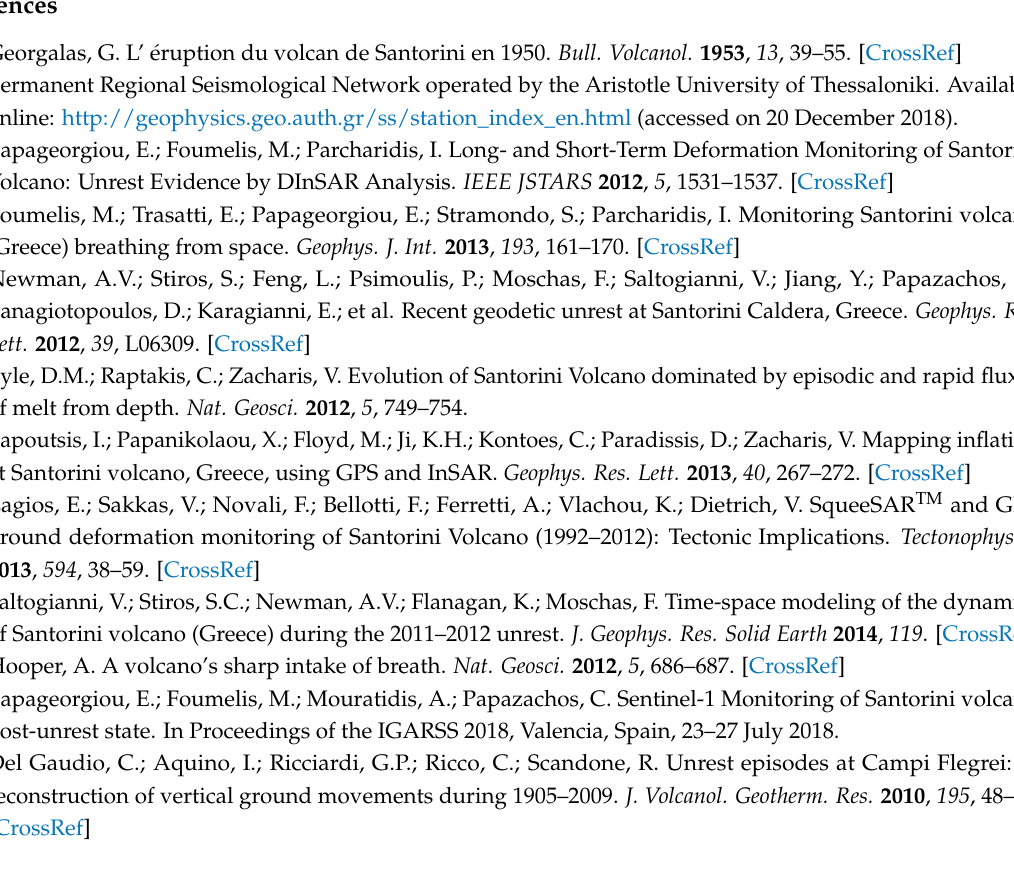
angles. Figure S3: Comparison between subsampled data (first column) and modeled data (second column) for the single source model of the post-unrest. The third column reports the residuals (observed data minus modeled data). (a–c) Ascending orbit track 029 (a029); (d–f) Descending orbit track 036 (d036); (g–i) Descending orbit track 109 (d109); (j–l) Descending radarsat-2 data (drs2). The shaded circle is the surface projection of the sill-like source with its actual radius (about 2000 m). The chi-square for this model is 3.5. Figure S4: Comparison between subsampled data (first column) and modeled data (second column). The third column reports the residuals (observed data minus modeled data). (a–c) Ascending orbit track 029 (a029); (d–f) Descending orbit track 036 (d036); (g–i) Descending orbit track 109 (d109); (j–l) Descending radarsat-2 data (drs2). The star is the center of the Kameni source, the shaded circle is the surface projection of the sill-like source with its actual radius. Figure S5: Posterior Probability Density (PPD) functions retrieved by the non-linear joint inversion of the two sources. (a,b) Coordinates of the centre of the sill-like source (S), (c) its depth, (d) radius, (e) potency, i.e., overpressure ∆ P vs rigidity µ ; (f,g) Coordinates of the spherical source (Mogi source, M), (h) its depth, (i) its volume variation. Easting and Northing are in UTM-WGS84 projection, zone 35. The dashed line is the mean model. Figure S6: Two-dimensional PPD distributions. Each panel represents the 2D distribution of the inverted parameters. Contour lines every 10% confidence. The red cross is the mean model listed in Table 3. Each panel reports the numbering of two parameters for which the 2D-distribution is computed, considering the exact order as reported in Figure S5 and Table 3, i.e., a) = 1, b) = 2, c) = 3, d) = 4, e) = 5, f) = 6, g) = 7, h) = 8, i) =